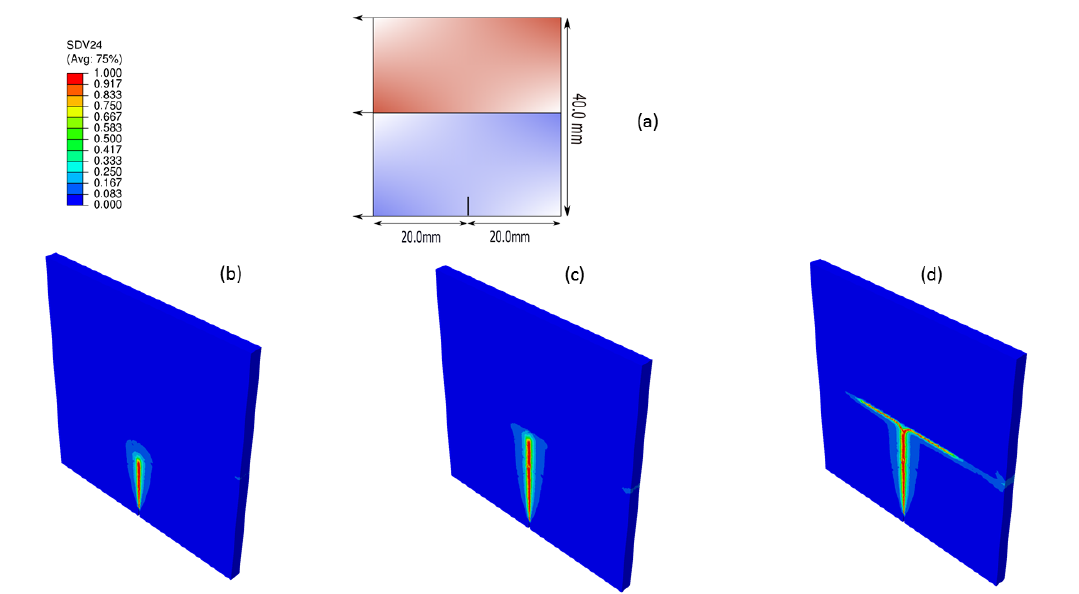
Figure 13. Crack propagation in a bi-material specimen: ( a ) representational 2-D geometry; thickness = 5 mm; ( b ) crack initiation; ( c ) crack propagation through the soft material; ( d ) crack reaches the material discontinuity junction; and ( e ) crack